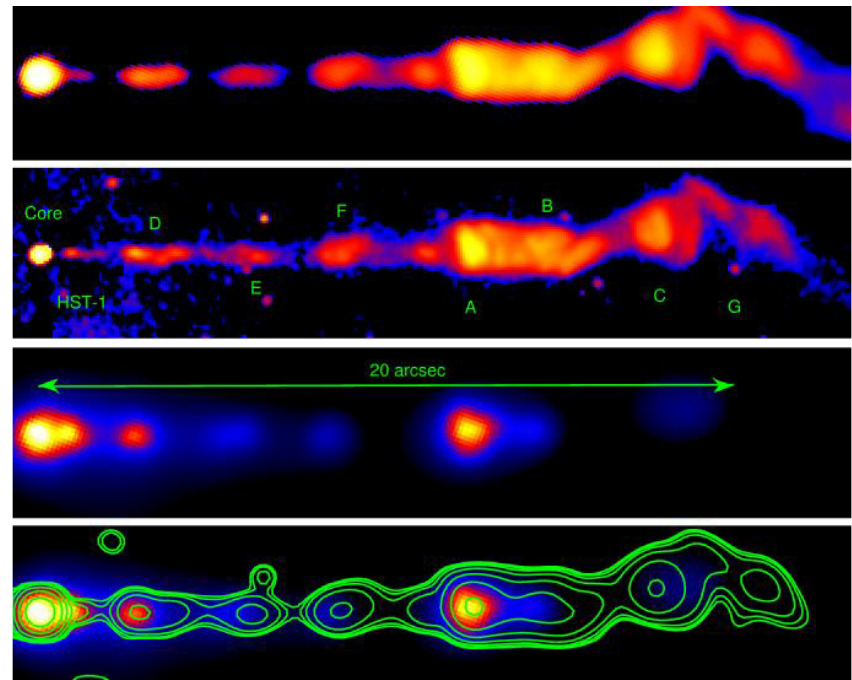
Figure 2. Multi-wavelength view of the M87 jet. From top to bottom: radio jet imaged by Very Large Array (VLA), optical jet seen by the Hubble Space Telescope, and X-ray image taken by the Chandra X-ray Observatory. The optical image (middle) marks the position of various bright knots/stationary features observed in the jet. (Credit: Marshall et al. [75], reproduced with permission c (cid:13) AAS).